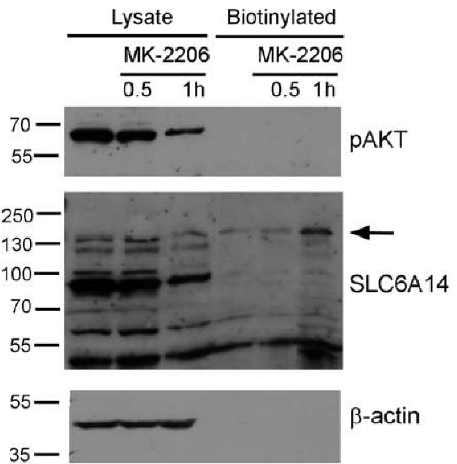
Figure 5. Effect of AKT inhibition on endogenous SLC6A14. MCF-7 cells were treated, where indicated, with 5 µ M MK-2206. The cells were subjected to the biotinylation of surface proteins, as described in Section 2.5. The biotinylated fraction (from 800 µ g protein) and the lysates (30 µ g protein) were subjected to Western blot analysis and probed with anti-phosphoAKT antibodies (pAKT) and antibodies directed against SLC6A14 and β -actin. The representative blot out of 3 independent experiments is shown. The arrow indicates the presence of SLC6A14 in the plasma membrane.